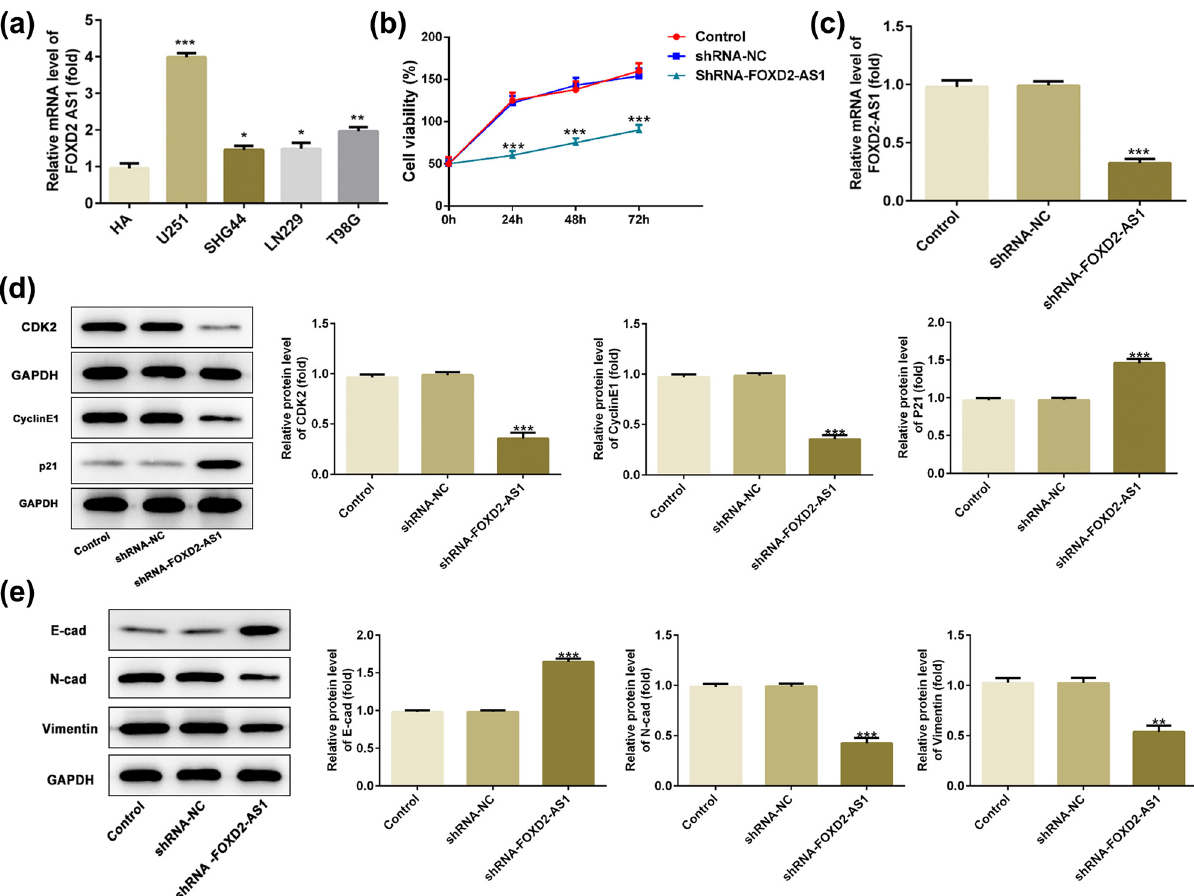
Figure 1: Overexpression of lncRNA FOXD2 - AS1 in four glioma cells, and silencing FOXD2 - AS1 inhibits cell proliferation and EMT of U251 cells. ( a ) RT - qPCR of FOXD2 - AS1 expression in human glioma cells, including U251, SHG44, LN229 and T98G cells, and normal HA cells. N = 5, * P < 0.05, ** P < 0.01 and *** P < 0.001 vs. HA. ( b ) FOXD2 - AS1 downregulation suppressed U251 cell viability in vitro . ( c ) FOXD2 -